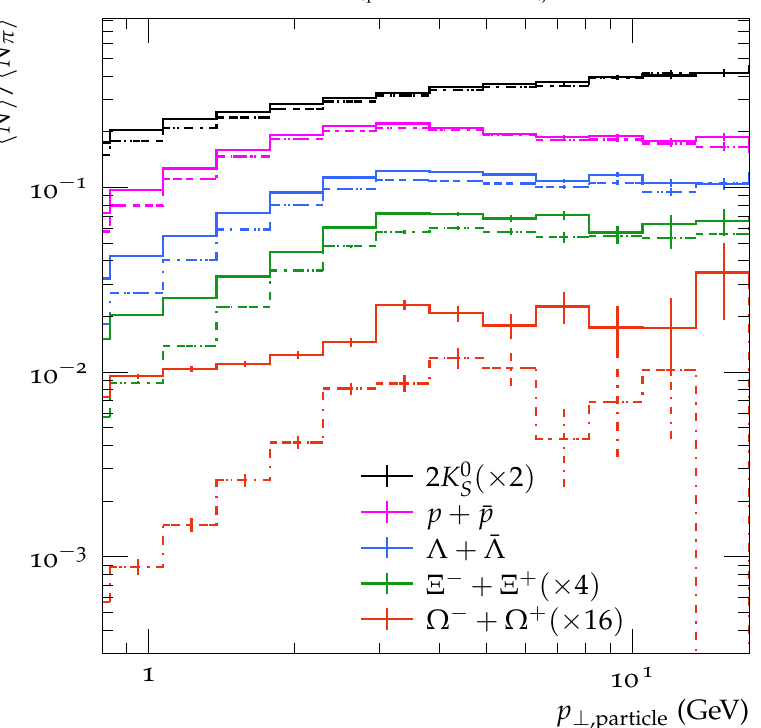
Figure 5: Yield ratio of different strange hadron species and protons to pions in the UE cone vs. p ⊥ , scaled by factors to show them clearly. Solid lines are with ,particle rope hadronization and dot-dashed lines are for default P YTHIA